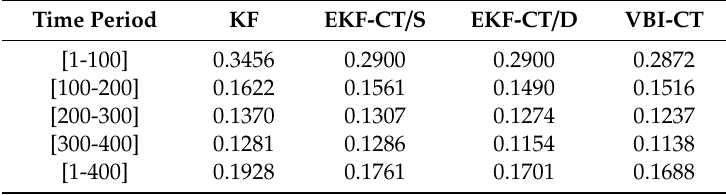
Table 3. Comparison of tracking error of di ff erent algorithms with σ 2 = 0.3.